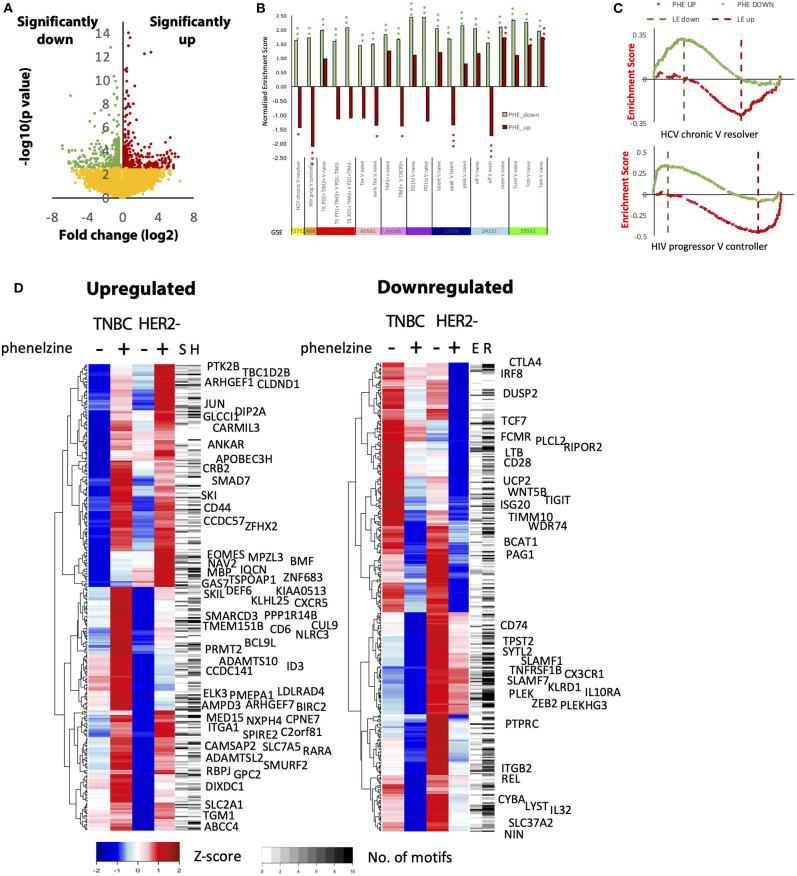
Global transcriptome analysis shows that phenelzine-mediated gene signatures are common to reinvigoration phenotypes in different model systems. (A) Volcano plot of the difference in gene expression before and after phenelzine treatment in TNBC and HER2− donor CD8+ T cell transcriptomes. Significance was determined in DeSeq2, FDR < 0.1, n = 4. Three hundred fifty genes were downregulated with phenelzine (PHE) treatment and 314 were upregulated. (B) Enrichment of the down (PHE_Down) and up (PHE_UP) PHE signatures in different models of T cell exhaustion, activation, and memory. For x vs. y comparisons, a positive normalized enrichment score (NSE) indicates enrichment in x, a negative score enrichment in y. *p < 0.05 **p < 0.01 ***p < 0.001. (C) Enrichment plots for GSE72752 and GSE24081 showing individual genes from the two phenelzine signatures distributed across the ranking in expression from chronic to resolver or progressor to controller. (D) Expression profiles of the genes up- and downregulated by phenelzine in the two donors (TNBC and HER2−). Averages of the duplicate isolations and treatments are shown (n = 2). The number of SMAD (S) and HIC2 (H) or EOMES (E) and RUNX1 (R) motifs in nearby enhancers are marked. Upregulated genes with at least 5 SMAD motifs in nearby enhancers or that are negative regulators of the TGF-b pathway are named. Downregulated genes with at least 5 EOMES motifs in nearby enhancers are named (red: direct (bound) EOMES targets upregulated by EOMES overexpression; blue: direct (bound) targets downregulated by EOMES overexpression).